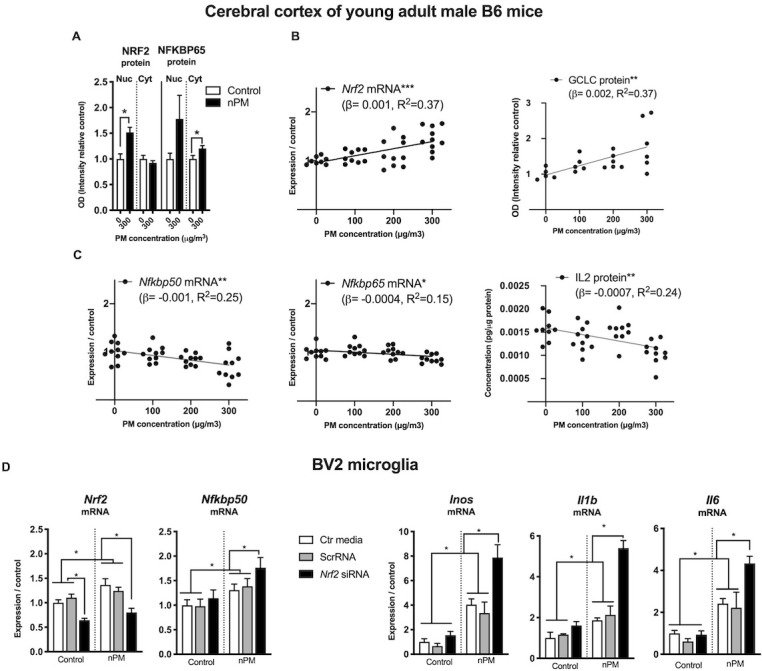
NRF2 and NFKB interact with nPM toxicity in cerebral cortex of male C57BL/6 mice and in mouse microglia (BV2 cells, in vitro).(A) Increased nuclear translocation of NRF2 and cytosolic NFKBP65 of B6 mice exposed to 300 μg/m3 nPM for three wks. (B) nPM exposure dose-dependent increase of Nrf2 mRNA and positive correlation with increase of GCLC protein. (C) nPM dose-dependent decrease of Nfkbp65 and Nfkbp50 mRNA, and IL2 protein levels. Inhalation exposure to nPM at 100, 200, and 300 μg/m3 nPM (in vivo sample size, 10/group; exposure, 5 hr/d, 3 d/wk, 3 wks. **p=0.001, ***p=0.0001. (D) BV2 microglia in vitro response to nPM at 5 μg/ml nPM for 6 hr after partial knockdown of Nrf2 (sample size, 6/group; two independent biological replicates). Nrf2 mRNA knockdown was >60% at time 0. ANOVA with FDR multiple test correction. Mean ± SEM. *Adj. p=0.05. nPM chemical characterization (Figure 1—figure supplement 1).